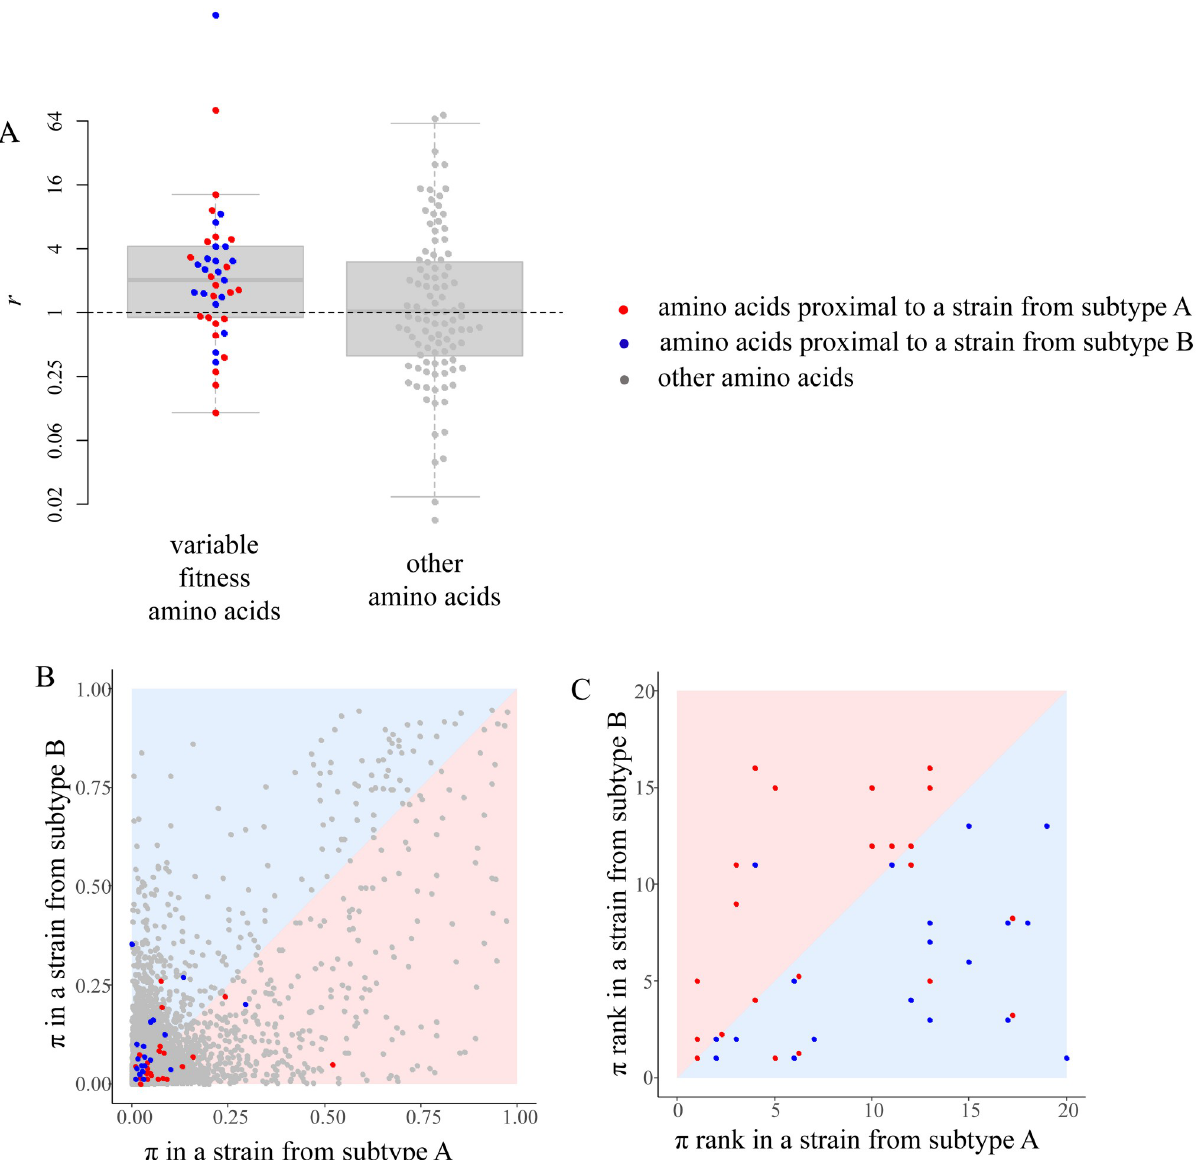
Fig 4. A , The ratio of DMS preferences π for an amino acid between the strain for which this amino acid is phylogenetically more proximal and the strain for which it is more distal. Amino acids with significant (left, p < 0.01 for both strains) or insignificant (right, p > 0.1 for both strains) changes in conferred fitness between strains are shown; bold line is the median, box borders represent the inter quartile range (IQR) between the first (Q1) and the third (Q3) quartiles, whiskers are Q1–1.5 � IQR and Q3 + 1.5 � IQR intervals, outliers are not shown; boxplots are made using all data; each variable amino acid significantly proximal to a strain from subtype A (BF520) or a strain from subtype B (LAI) and a subsample of 100 other amino acids are shown as red, blue and grey dots respectively. The dashed line indicates no change in preferences ( r = 1). B , C , Experimentally measured fitness π ( B ) or fitness rank ( C , with rank 1 corresponding to the fittest amino acid) of each amino acid in the two strains of HIV-1. Grey dots, amino acids that have been observed at least in one strain in our phylogenetic tree; red, variable fitness amino acids that are proximal to a strain from subtype A (BF520); blue, variable fitness amino acids that are proximal to a strain from subtype B (LAI); colored areas indicate the expected positions for dots of corresponding color.